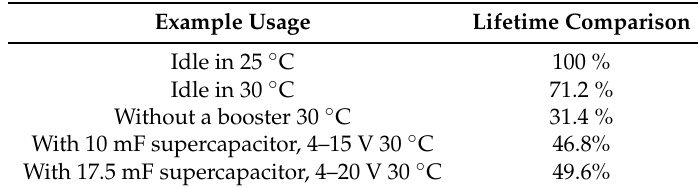
Table 2. Comparison of the estimated battery lifetime.